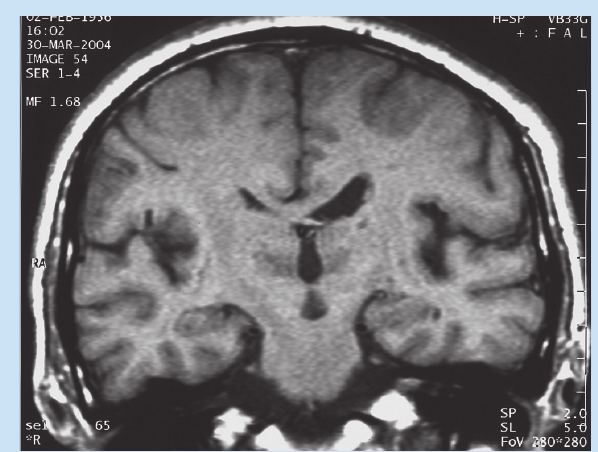
Fig. 2. Coronal T1-weighted image with bilateral low signal intensities in the thalami.